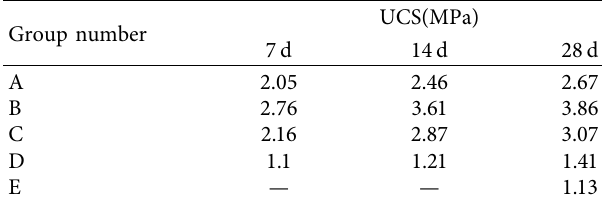
Figure 6: Stress-strain curve of SRLS. (a) A-1 group (0% content of SR). (b) B-1 group (3% content of SR). (c) C-1 group (6% content of SR). (d) D-1 group (9% content of SR). Table 5: UCS of SRLS.